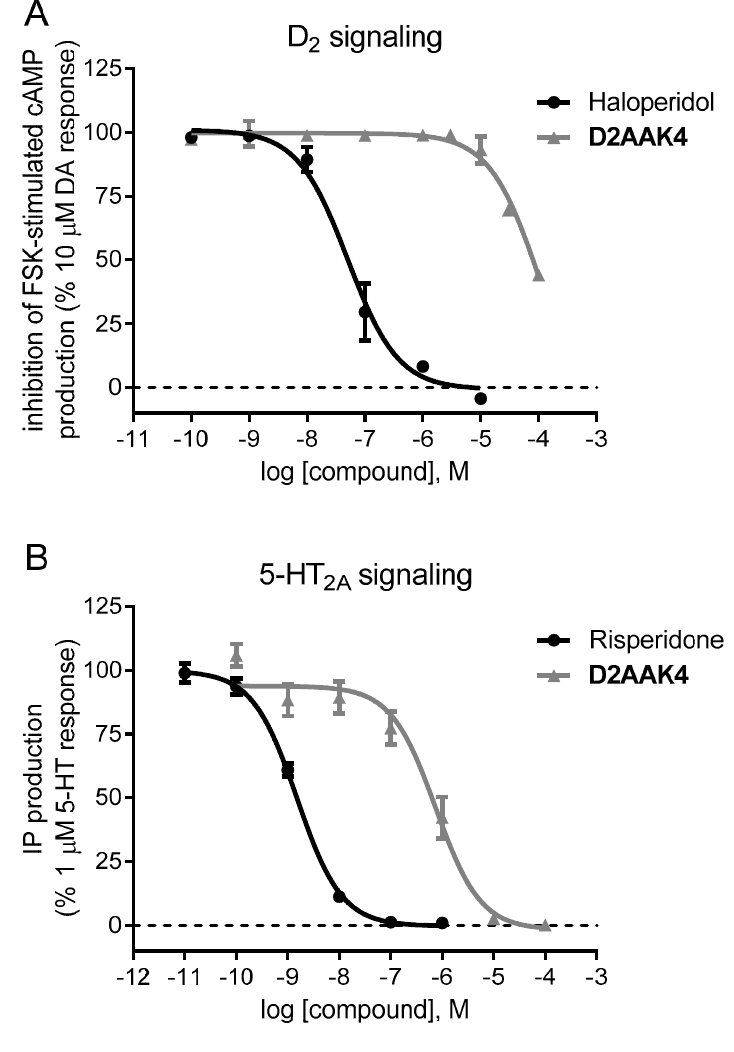
Figure 2. Functional assays for D2AAK4 at D 2 and 5-HT 2A receptors. A —Concentration-response curves of D2AAK4 and haloperidol (as reference antagonist) on the inhibition of forskolin (FSK)-stimulated cAMP production by 10 µM dopamine (DA) in CHO-K1 cells expressing human-cloned D 2 receptors. The graph shows data (mean ± SEM) of two independent experiments performed in duplicate. B —Concentration-response curves of D2AAK4 and risperidone (as reference antagonist) on IP production stimulated by 1 µM 5-HT in CHO-K1 cells expressing human cloned 5-HT 2A receptors. The graph shows data (mean ± SEM) of three independent experiments performed in duplicate or triplicate.